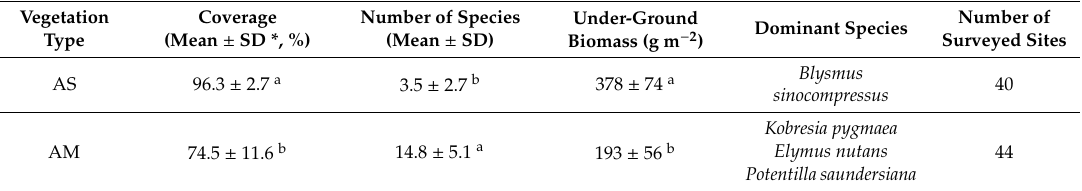
Table 1. Characteristics of the surveyed AS and AM communities in the study area. Vegetation